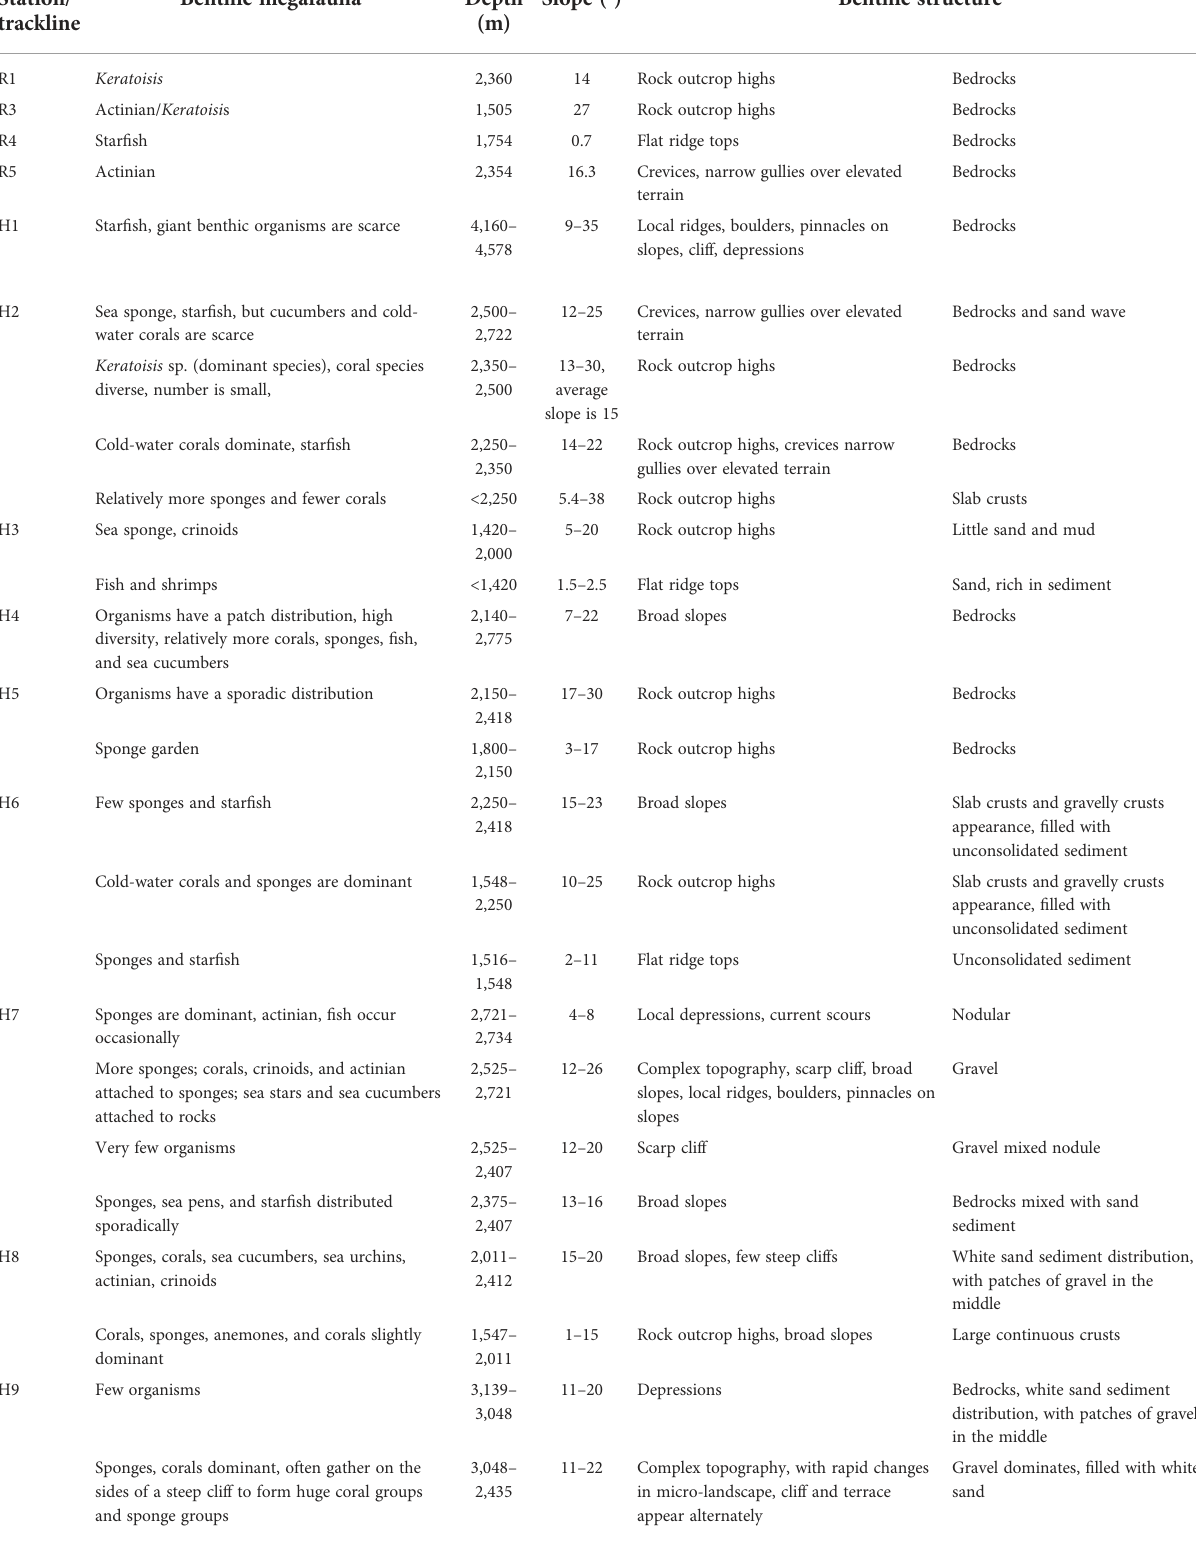
TABLE 7 Megafauna occurrences and related benthic